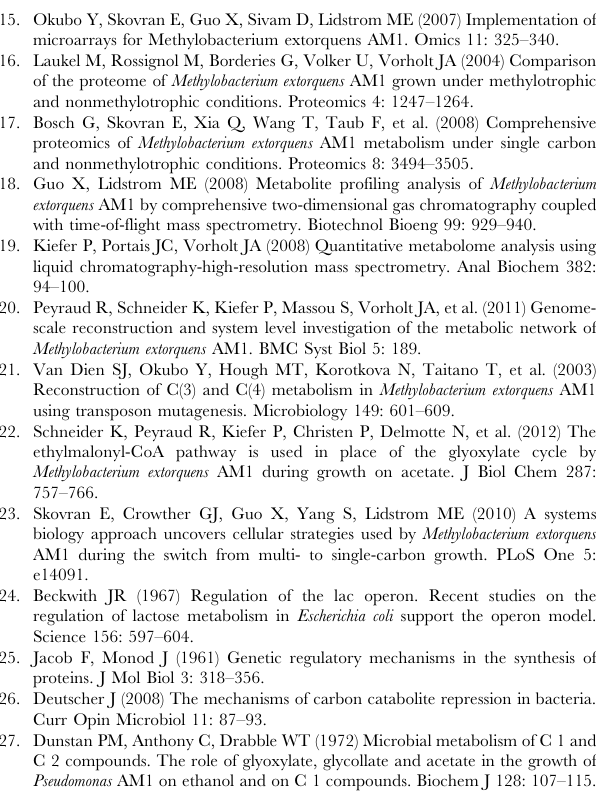
Figure S1 Mass isotopomers distribution of central metabolites measured by LC-MS of M. extorquens AM1 upon co-consumption with 13 C ( . 99%) methanol and natural abundance (1.1% 13 C) succinate. Mass isotopomer data in black correspond to samples collected during mid-co-consumption phase (Sampling time 1, see Fig. 1), and in red to samples collected at the end of the co-consumption phase (Sampling time 2). Figure S2 Average 13 C labeling in intra-cellular meta- bolites measured by LC-MS of M. extorquens AM1 at 90 minutes after succinate exhaustion (Sampling time 3 on Fig. 1). Figure S3 Mass isotopomers distribution of central metabolites measured by LC-MS of M. extorquens AM1 at 90 minutes after succinate exhaustion (Sampling time 3 of Fig. 1). Figure S4 Mass isotopomers distribution in CoA thioe- sters measured by LC-MS during growth of M.extor- quens AM1 upon co-consumption with 13 C ( . 99%)